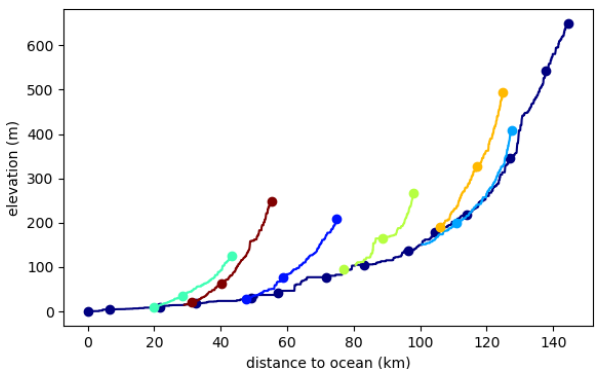
Figure 4. Examples of hypsometry curves for the rivers in Fig. 2.